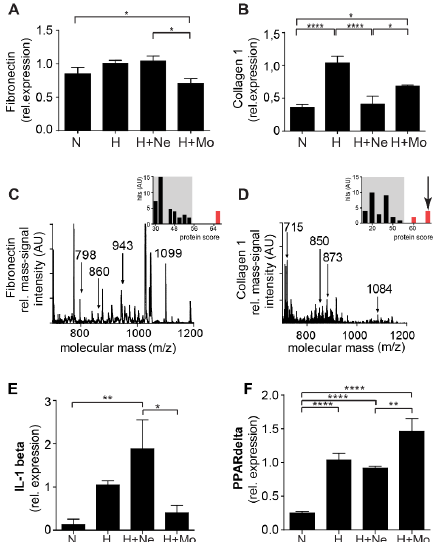
Figure 2. The effect of neutrophil-fraction on extracellular matrix protein synthesis. ( A ) Fibronectin mRNA expression and ( B ) collagen mRNA expression in isolated fibroblasts cultured in normoxia (N), hypoxia (H) and co-cultured with neutrophil (Ne) fraction (H+Ne) and mononuclear (Mo) fraction (H+Mo), respectively ( n = 9, * p < 0.05, **** p < 0.0001). ( C ) Characteristic matrix-assisted laser desorption/ionization (MALDI) mass fingerprint-spectrum of tryptic peptides of fibronectin ( n = 3). (D) Characteristic MALDI mass fingerprint-spectrum of tryptic peptides of collagen I detected in isolated fibroblasts co-incubated with mononuclear fraction ( n = 3). Protein scores from the Mascot database are shown for each identification in right insets (arrow indicates the identified protein). Neutrophils (H+Ne) increased the gene expression of ( E ) IL-1ß ( n = 9), while mononuclear cells (H+Mo) increased the gene expression of ( F ) PPAR γ ( n = 9). (* p < 0.05; ** p < 0.01; **** p < 0.0001).